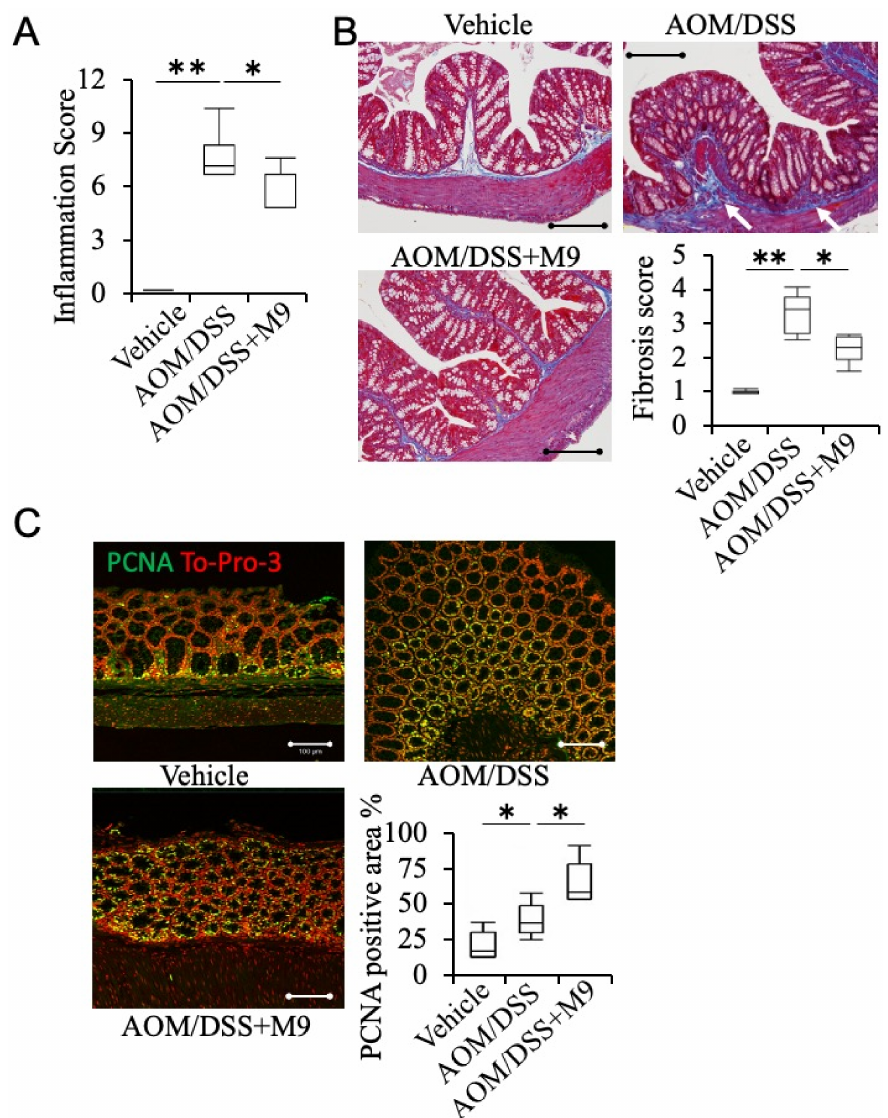
Figure 3. Treatment of Probio-M9 ameliorated AOM/DSS-induced fibrosis and accelerated tis- sue repair in non-tumor areas. ( A ) Inflammation score in non-tumor areas was evaluated from hematoxylin-eosin (HE) histological sections of the colons. n = 10. ( B ) Representative images of the non-tumor areas of the colon evaluated with Masson’s trichrome (MT) staining and the corresponding fibrosis scores. Averaged fibrosis score was grouped as 0%, 1–25%, 26–50%, 51–75%, or 76–100% of the submucosa affected corresponding to a fibrosis score of 0, 1, 2, 3, and 4, respectively. n = 10. Scale bar: 200 µ m. ( C ) Representative image of immunohistochemistry staining of PCNA in non-tumor areas. To-Pro-3 was used to label the nucleus. The ratio of the expression area in the mucosal layer is shown in the graph. n = 5. * p < 0.05; ** p < 0.01. Scale bar: 100 µ